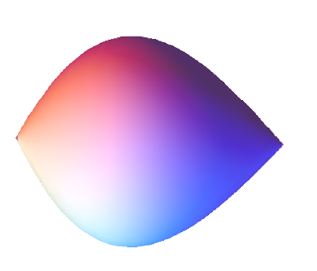
Figure 10 . A two-dimensional projection of the internal space M